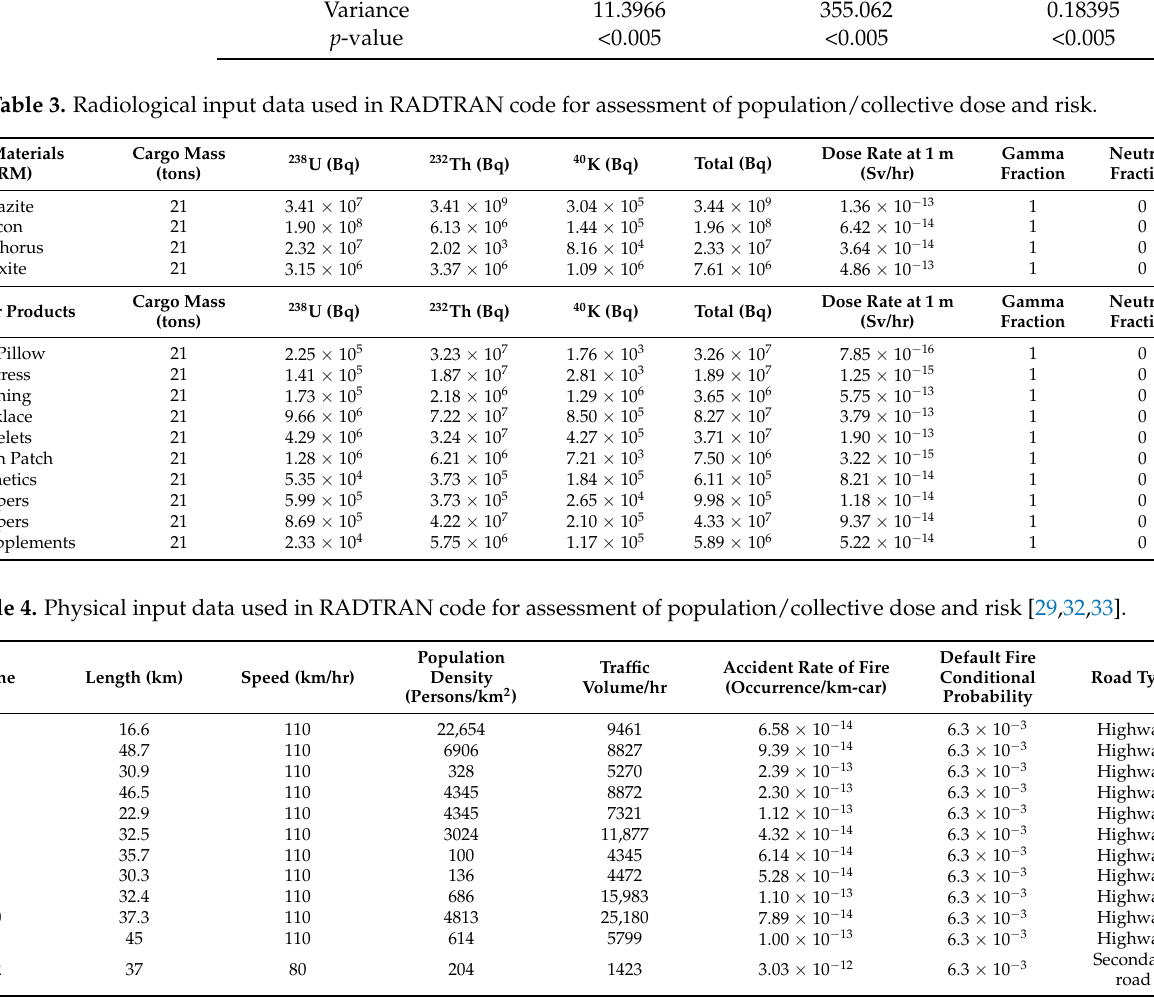
Table 5. Physical input data used in RADTRAN code for assessment of population/collective dose and risk. Critical